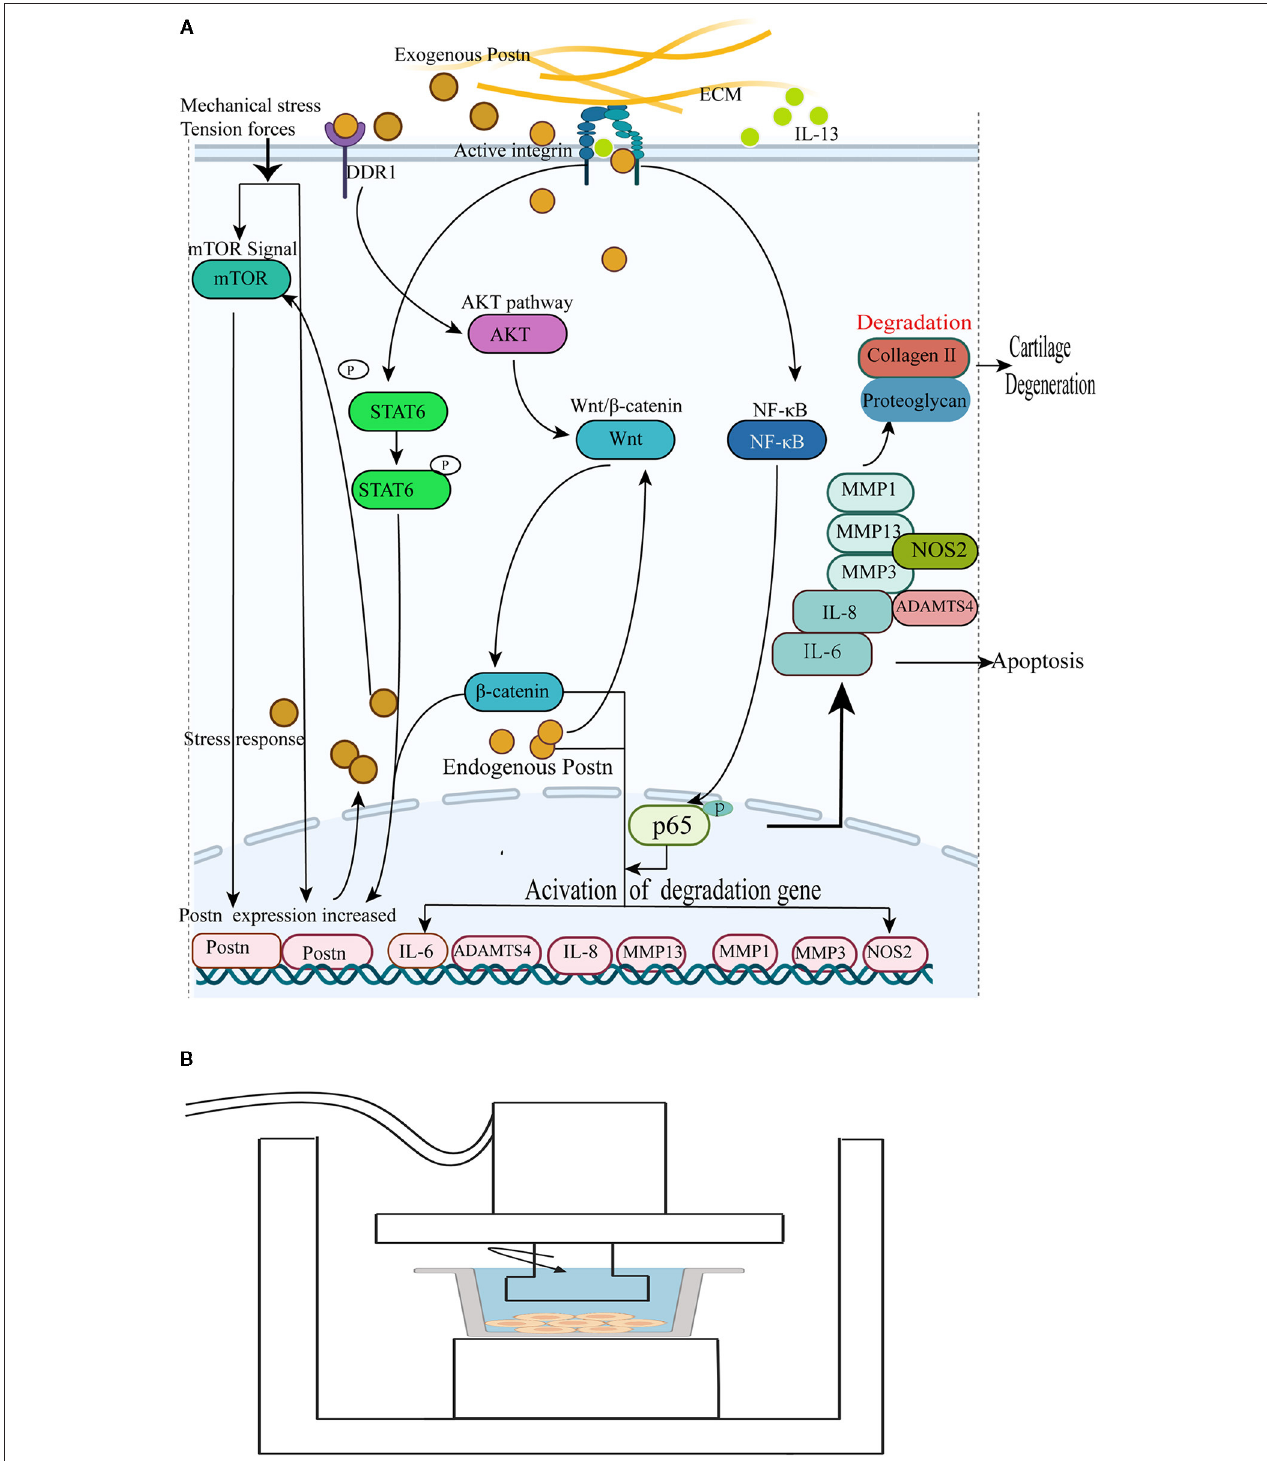
FIGURE 4 | (A) POSTN promotes collagen and proteoglycan degradation to accelerate cartilage degeneration and loss. (1) Endogenous POSTN can promote the expression of MMP13 and ADAMTS4 by activating the canonical Wnt/ β -catenin signal pathway to accelerate cartilage degeneration and chondrocyte apoptosis. (2) POSTN leads to the activation of the NF- κ B signaling pathway, denoted by the nuclear translocation of p65, and subsequently upregulates IL-6, IL-8, MMP1, MMP3, MMP13, and NOS2 to induce chondrocyte apoptosis and accelerate cartilage degeneration. (3) IL-13 promotes the phosphorylation of STAT6 and activates STAT6